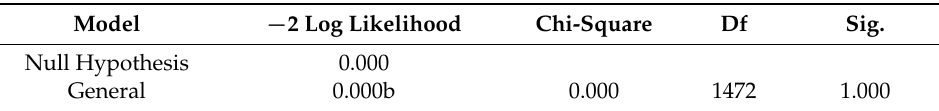
Table 4. Chi-square; test of parallel lines goodness of fit.